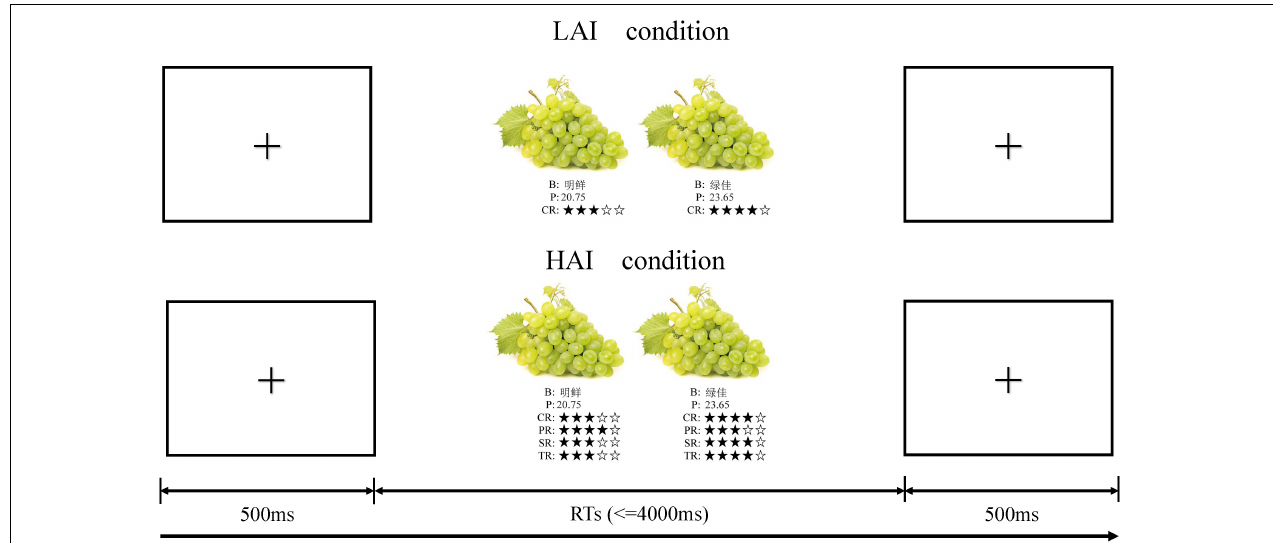
FIGURE 1 | Experimental task. Participants were instructed to make purchase decisions under different information volume conditions. B for brand, P for price, CR for climate rating, PR for precipitation rating, SR for sunshine rating, and TR for temperature rating.